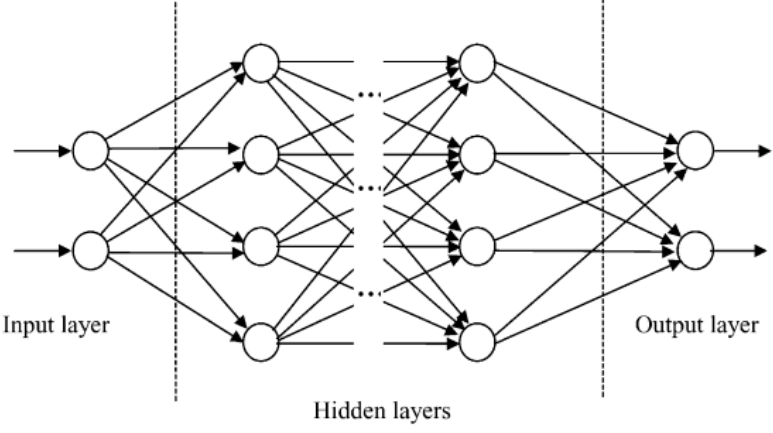
Figure 1. Representation of an MLP network. Adapted from ATA [28].